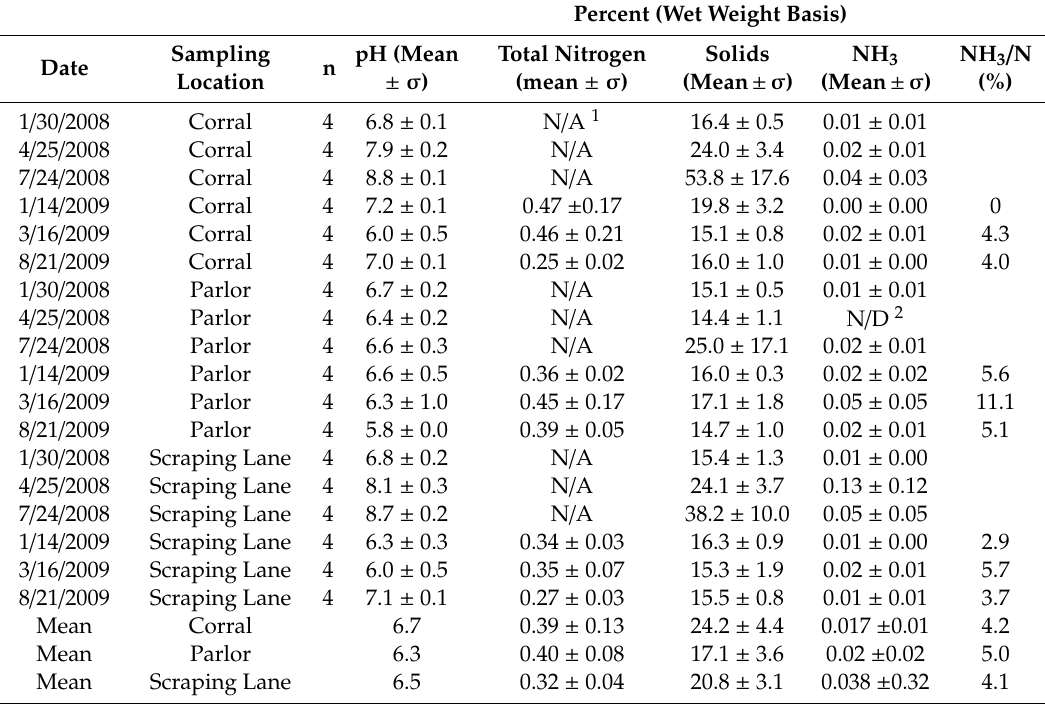
Table 4. Solid manure